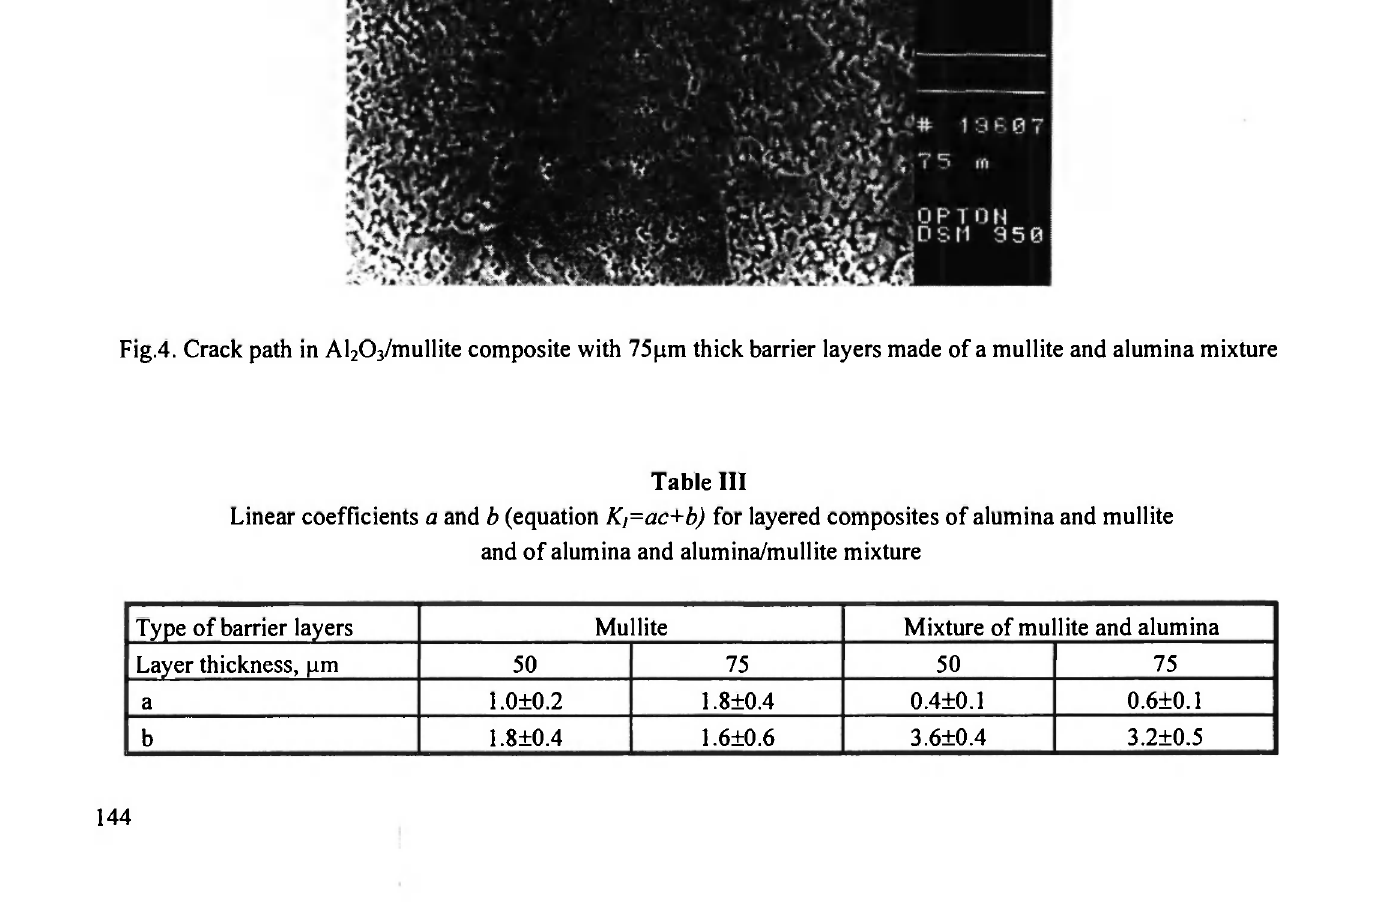
Type of barrier layers Mu llite Mixture of mullite and